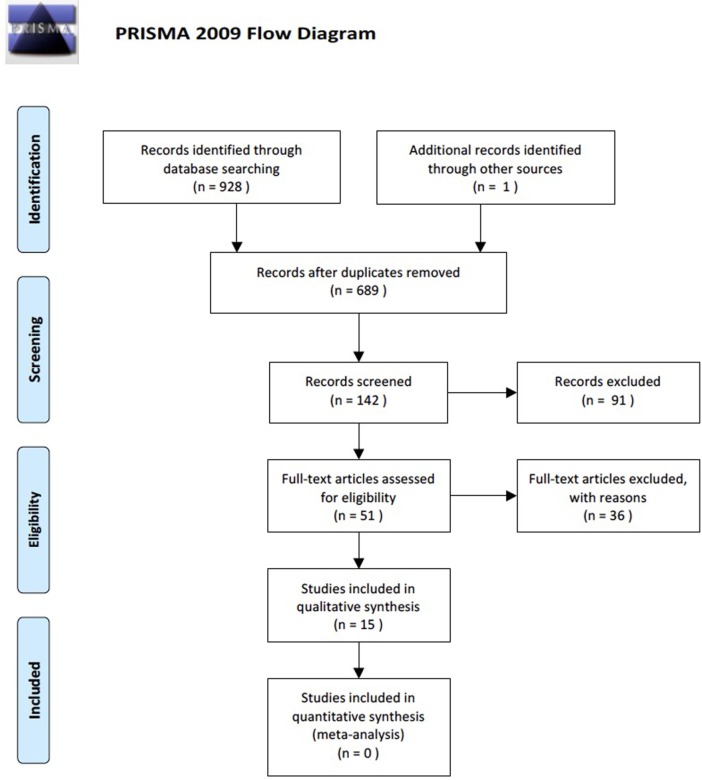
PRISMA flow chart outlining the number of details of the literature search with the total number of article gathered and the articles that met or did not meet inclusion criteria.